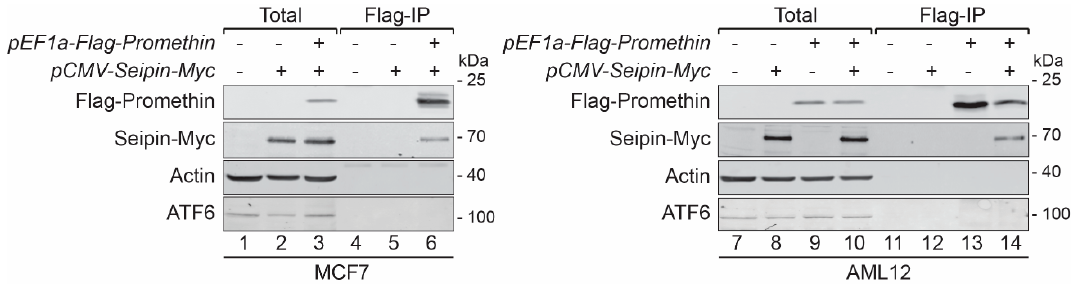
Figure 3. Promethin forms a complex with the LD biogenesis protein seipin. MCF7 and AML12 cells transfected with plasmids for expression of Flag-promethin and/or seipin-Myc were treated with 200 µM oleic acid for 48 h and subjected to immunoprecipitation using agarose beads coupled to Flag-antibodies, and eluted proteins were analyzed by SDS-PAGE and Western blotting. Seipin is specifically co-isolated with promethin, while the endoplasmic reticulum (ER) membrane protein ATF6 is not detectable in immunoprecipitations.